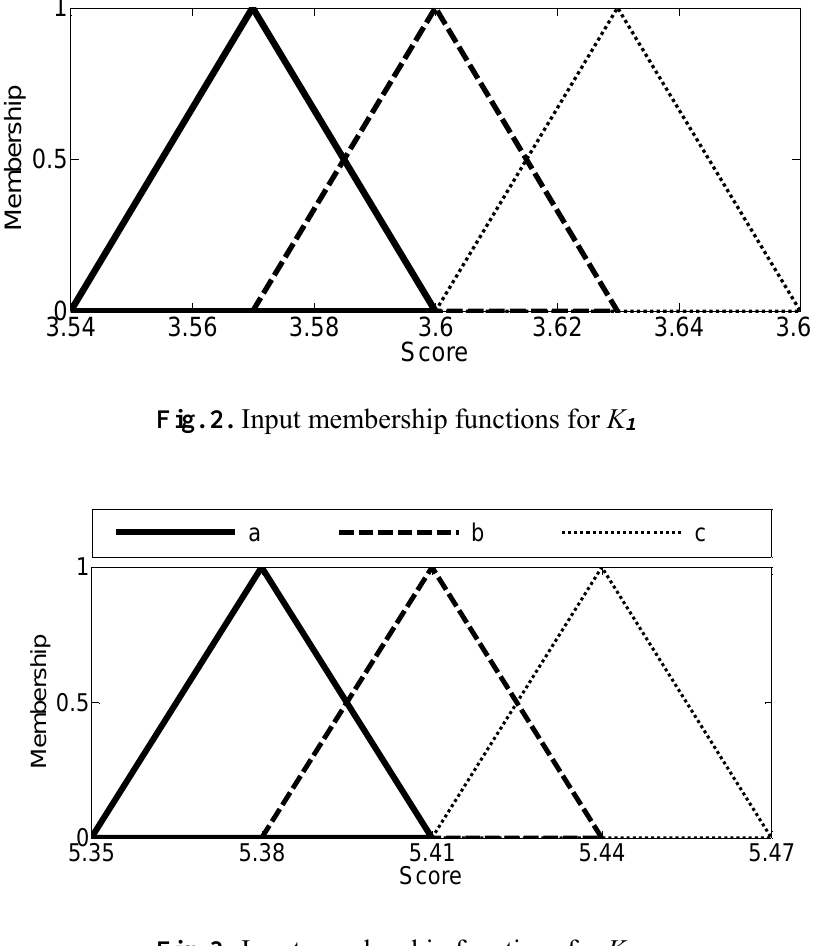
Fig. 3. Input membership functions for K